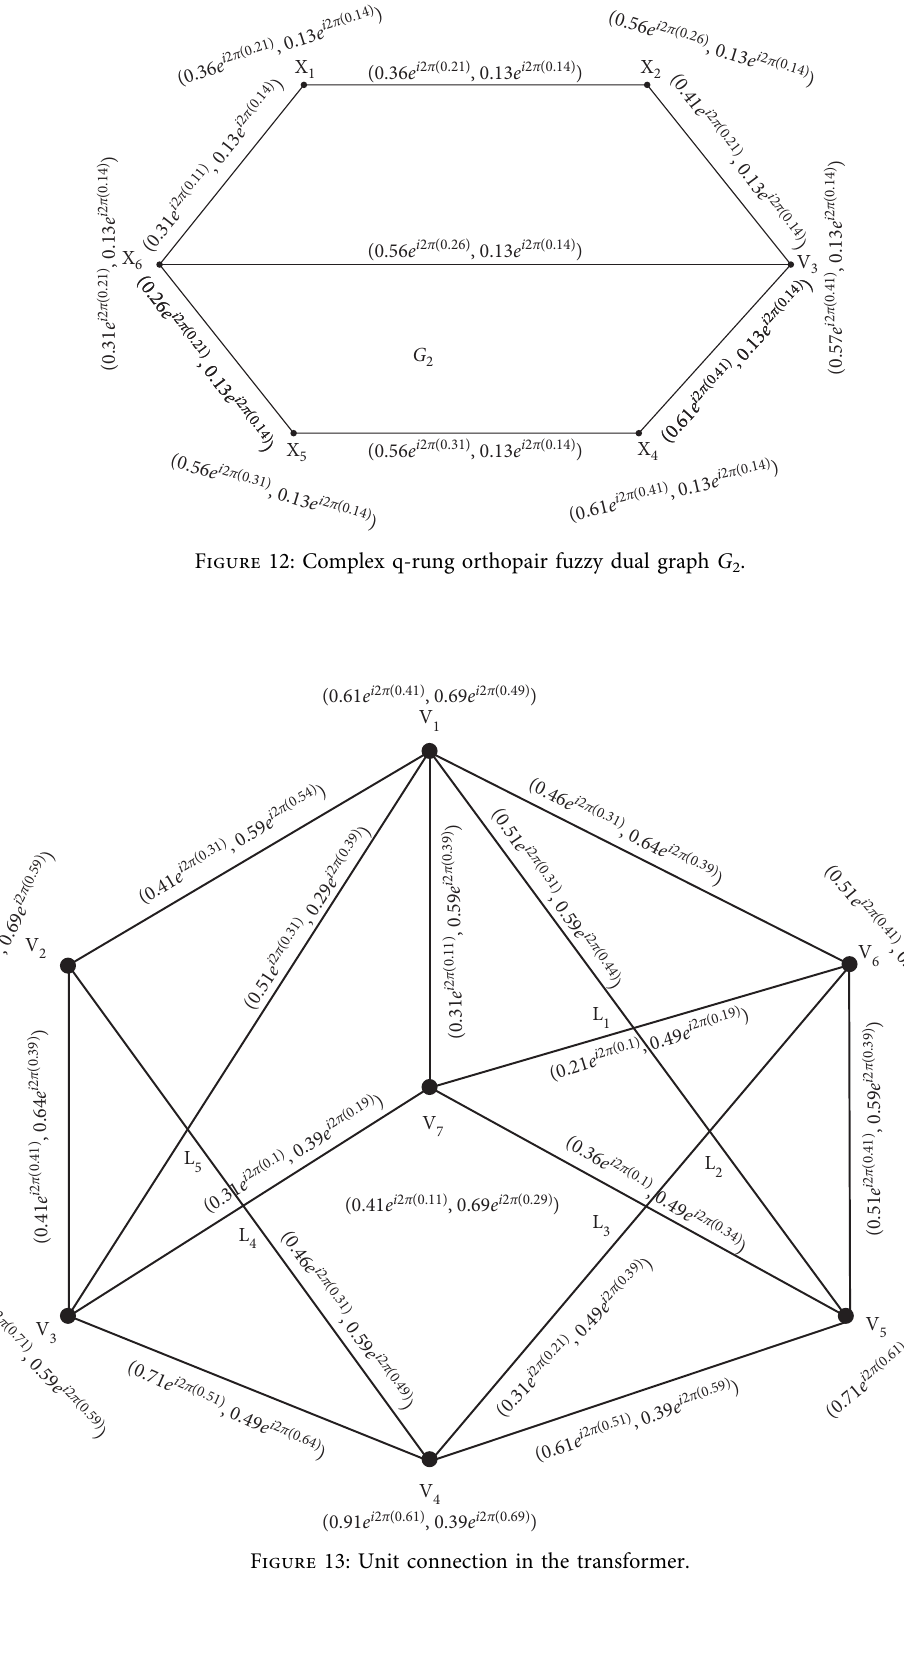
Figure 13: Unit connection in the